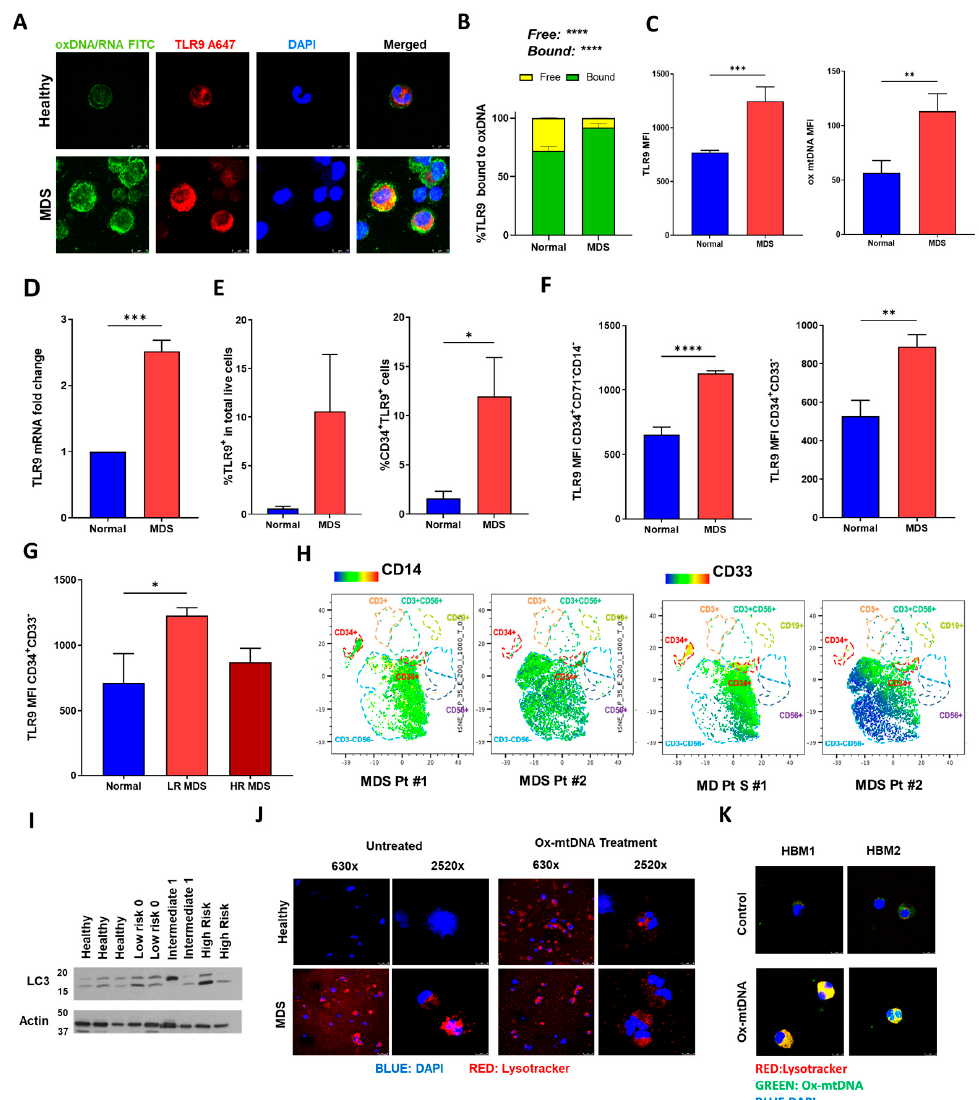
Figure 2. MDS HSPCs Display Surface TLR9 Induced by Cell-Free ox-mtDNA. ( A ) Confocal IF of colocalized TLR9 and ox-mtDNA in MDS BM-MNC samples compared with normal BM-MNC samples ( × 2520, DAPI, ox-mtDNA FITC, TLR9 A647). Representative Micrographs. ( B ) Mander’s Coefficient of Colocalization TLR9 bound to ox-mtDNA (Normal n = 3 and MDS n = 3). Significance measured by two-way ANOVA. ( C ) Quantification of mean fluorescence intensity (MFI) of TLR9 and oxDNA as in 2A, comparing Normal and LR MDS BM-MNCs (minimum 200 cells per sample, three samples per groups, mean MFI ± SEM). Significance measured by unpaired t -test. ( D ) Quantitative PCR to assess the relative expression of TLR9 mRNA (mean ± SEM. Normal n = 4, LR MDS n = 4). Significance measured by paired t -test. ( E ) Percent of cells expressing surface TLR9 measured by flow cytometry in either total live cells (left panel) or CD34 + TLR9 + from all live cells (Normal = 4, MDS = 13). Significance measured by Welch’s t -test. ( F ) CD34 + , CD71 - , CD14 ‒ cells, and CD34 + CD33 - (Normal = 3, MDS = 6). Significance measured by unpaired t -test. ( G ) Common Myeloid Progenitors, CD34 + , CD38 - (Normal = 3, LR MDS = 3, HR MDS = 3). Significance measured by ordinary one-way ANOVA. ( H ) Flow cytometric tSNE analysis of TLR9 distribution in CD14 + and CD33 + populations (two representative MDS specimens are shown, an enlarged visualization of this figure is also in Supplemental Figure S6). ( I ) Western blot of healthy and MDS BM-MNC lysates probed for the lysosomal marker LC3 and actin (3 Normal donors and 6 MDS donors with risk as shown). ( J ) Representative confocal IF micrographs showing increased lysotracker in MDS BM-MNCs compared to Healthy BM-MNCs; this increase is phenocopied in Normal BM-MNCs following treatment with 50 ng/mL ox-mtDNA for 2 h. [DAPI (blue), Lysotracker (Red)]. Three independent experiments. Nu- clear MFI quantified in Supplemental Figure S7). ( K ) Confocal IF of Healthy BM-MNCs, control and